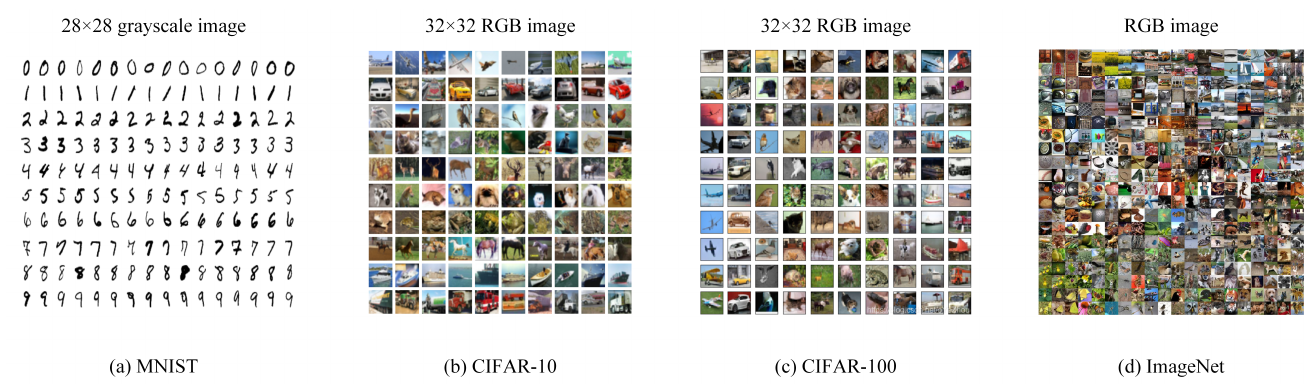
Figure 38. Visual image classification datasest (small part). ImageNet’s original image does not have a fixed